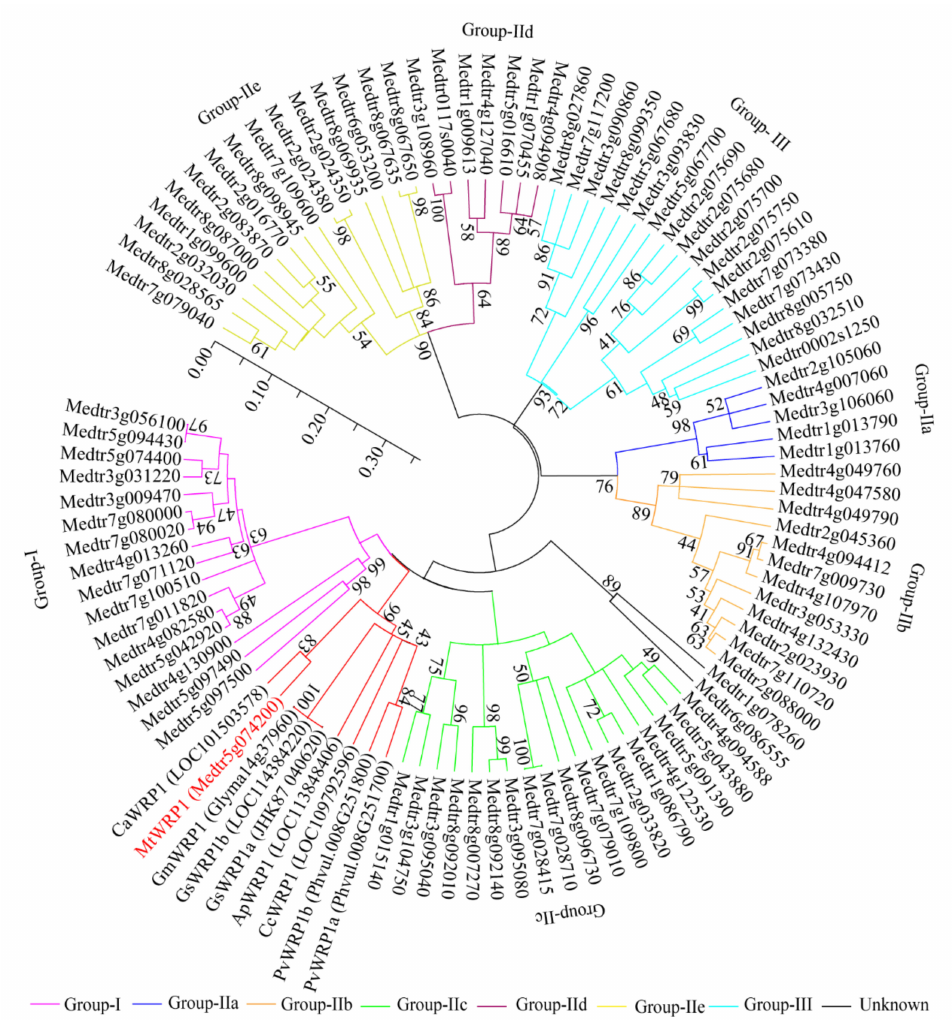
Figure 3. The phylogenetic analysis of MtWRP1, WRPs in different fabacean plants and the WRKYs in M. truncatula . The phylogenetic tree was generated from full-length amino acid sequences by MEGA 5 using the Neighbor-joining method. Numbers on branches indicated bootstrap values for 1000 replicates. The scale bar indicated the length of branch, reflecting the ancient divergence of these genes from each